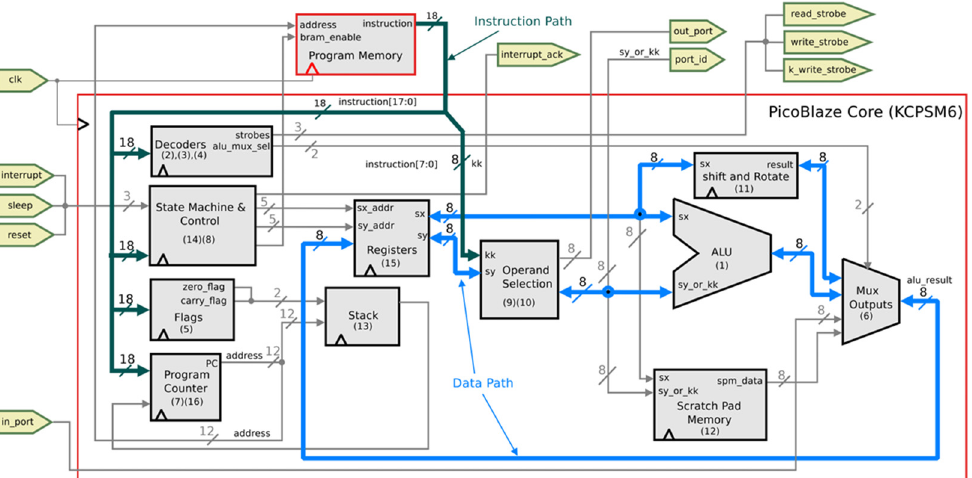
Figure 4. Block diagram of modular Zipi8 (a high-resolution version of this figure is available in Supplementary S3).